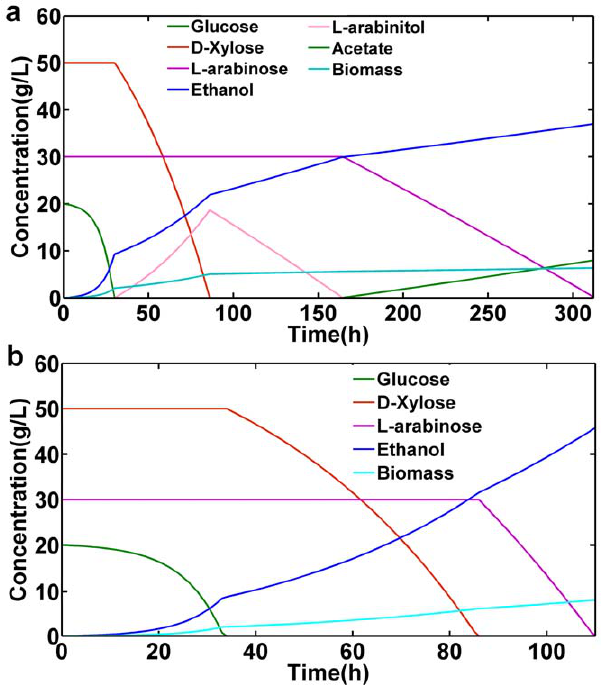
Figure 2. Dynamic flux balance analysis. Glucose, D-xylose, L- arabinose, L-arabinitol, acetate, ethanol and biomass are shown as a function of time for microaerobic S. cerevisiae batch growth on glucose, D-xylose, and L-arabinose. (a) engineered cofactor imbalanced (ECI) model. (b) engineered cofactor balanced (ECB) model.